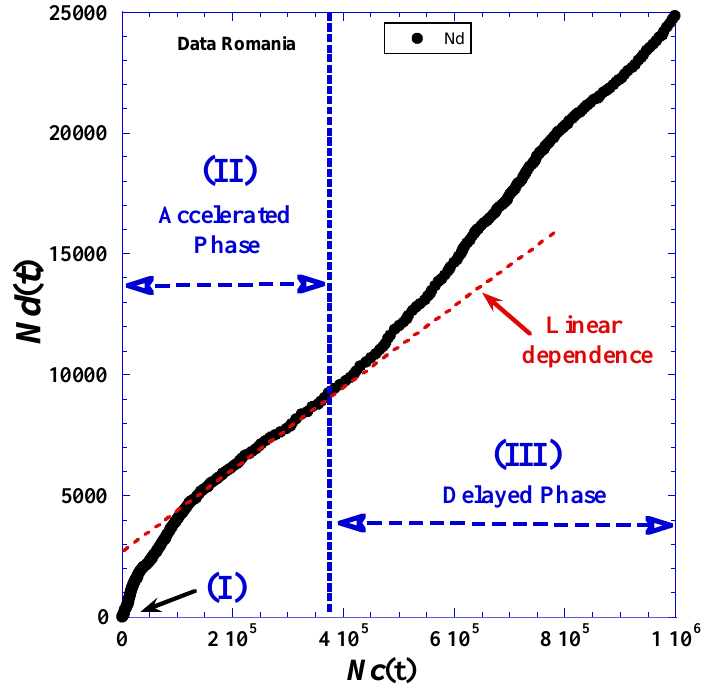
Figure 4. Cumulative deaths N d ( t ) versus the total reported cases Nc ( t ) for the first 350 days of the pandemic in Romania.